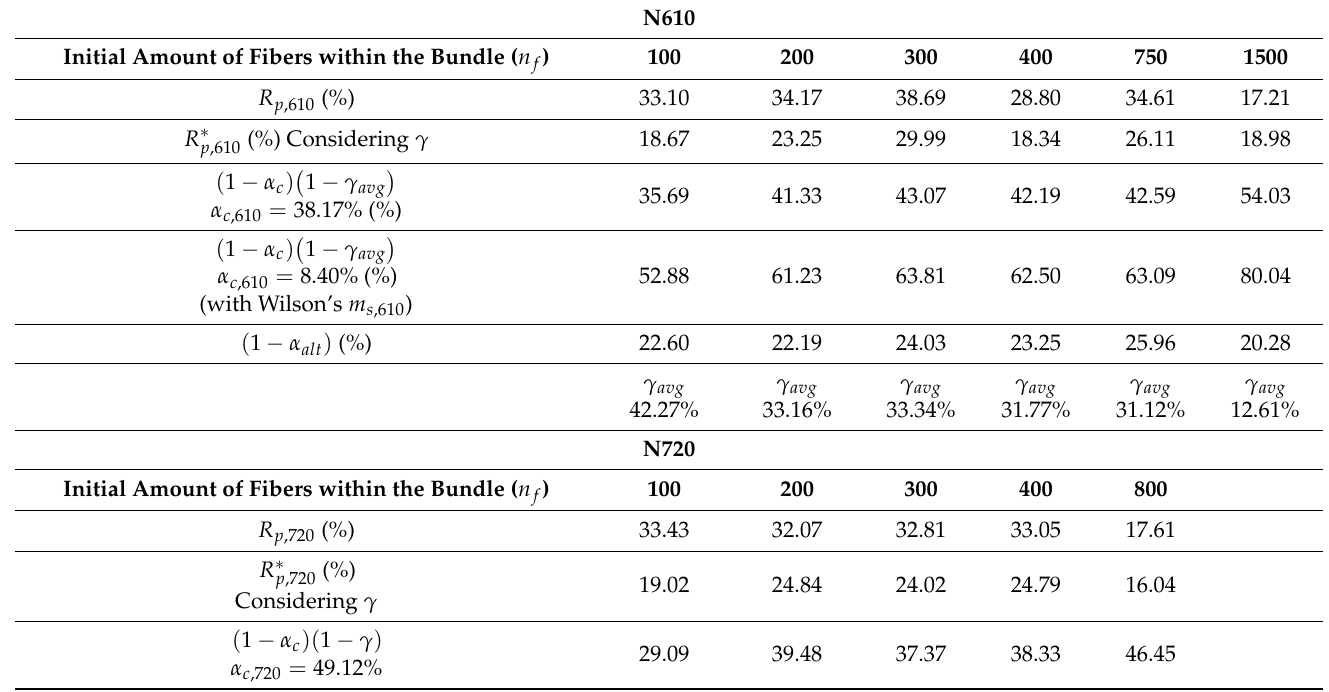
Table 6. Final fraction of fibers obtained through different